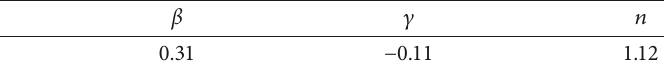
Table 2. The maximum absolute control error for the HOB